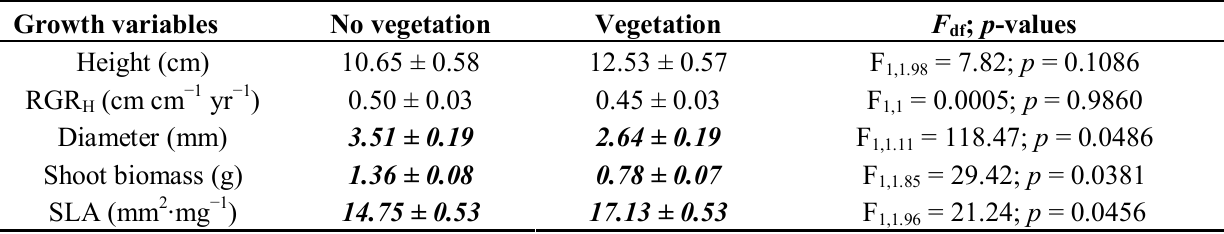
Table 3. Effects of the presence of vegetation on five variables related to the growth of red oak seedlings in August, 2011.